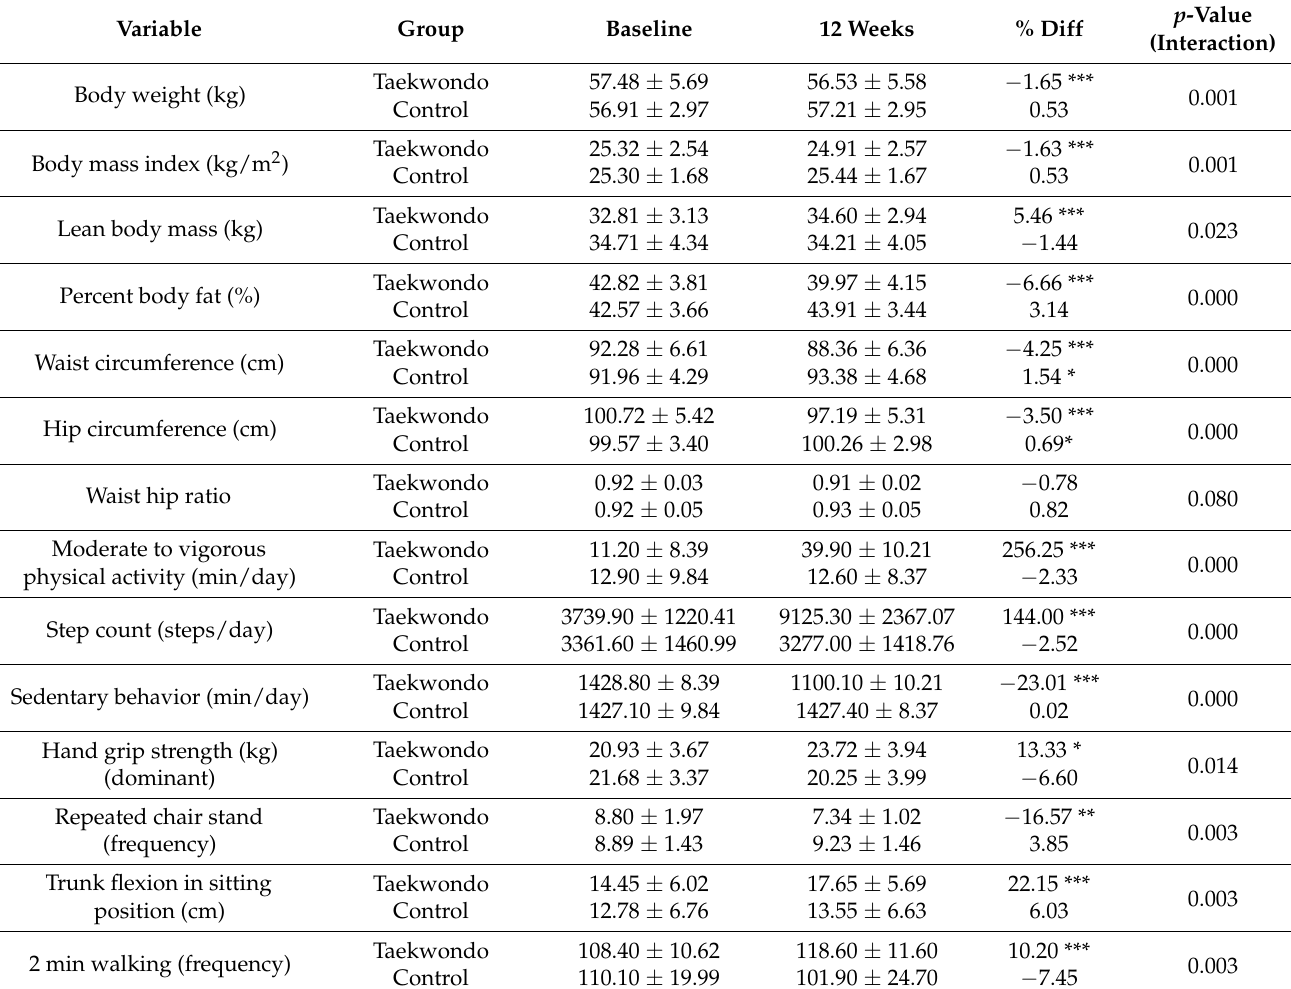
Table 3. The changes of body composition and daily physical activity and health-related physical fitness between the groups at baseline and after 12